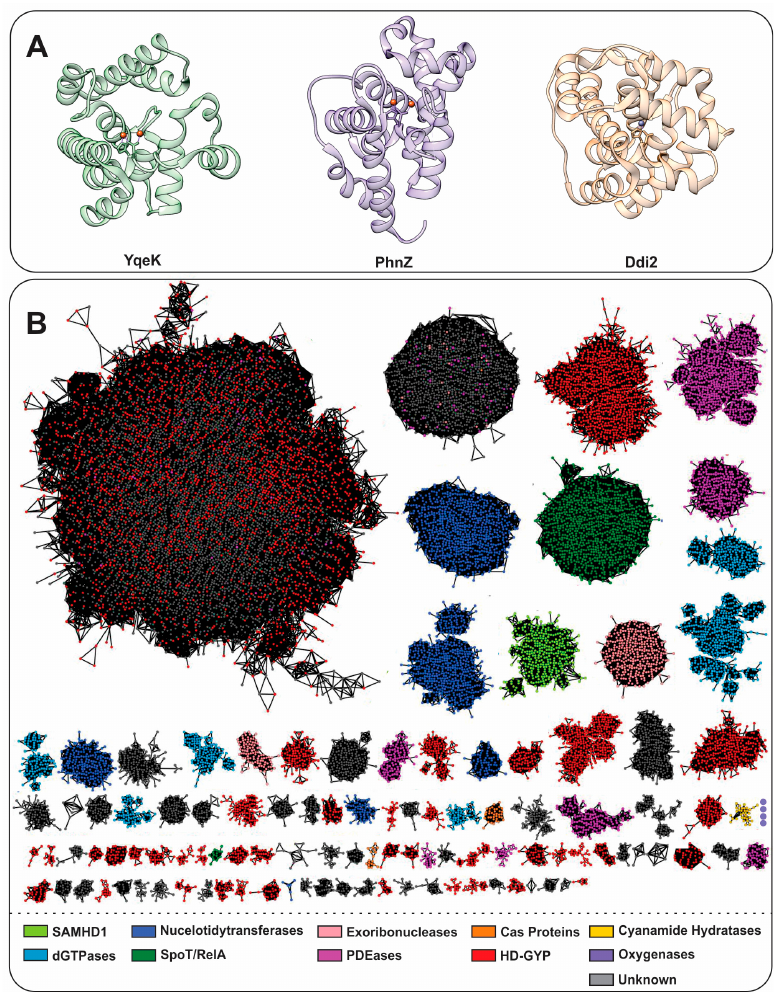
Figure 1. ( A ) Helical structure of three HD-domain proteins. YqeK (PDB: 2O08) is a phosphatase, PhnZ (PDB: 4N6W) is an oxygenase, and Ddi2 (PDB: 6DKA) is a lyase. All exhibit a helical fold characteristic to HD-domain proteins despite their diverse functions. ( B ) Sequence similarity network (SSN) of the HD-domain superfamily depicting its size and functional clustering. The SSN was generated via the Enzyme Function Initiatives-Enzyme Similarity tool (EFI-EST) and visualized in Cytoscape. The SSN was generated by employing the IPR003607 family and tailored so that nodes represent sequences with ≥ 50% identity and an e-value of 5. The SSN was further refined to contain the major protein clusters (size-wise), which amount to 183,015 unique protein sequences. Edges between nodes represent an alignment score of 70. HD-domain phosphohydrolases (SpoT / RelA, SAMHD1, deoxyguanosine phosphatases (dGTPases), nucleotidyltransferases) are represented in green and blue, while hydratases are shown in yellow. PDEs are shown in red (HD-GYP proteins), light pink (exoribonucleases), orange (Cas proteins), and pink (PDEases). Oxygenases are shown in purple and their cluster, which consists of four nodes (372 sequences), is enlarged for visualization. Gray clusters contain proteins of unidentified